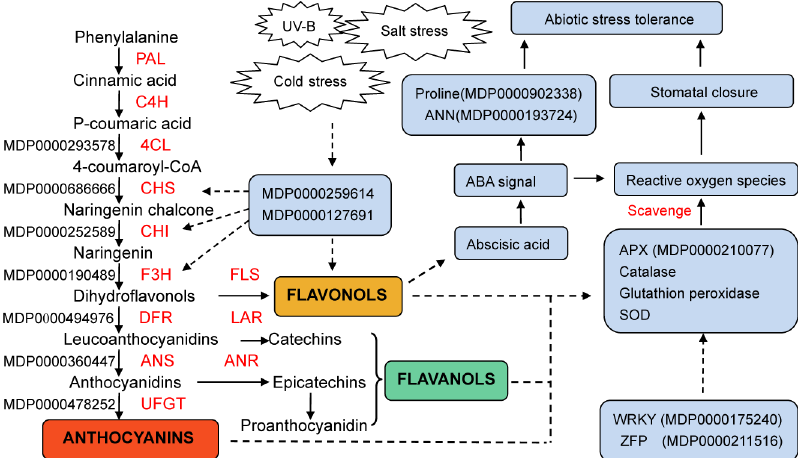
Fig 7. Model of the regulatory network involved in flavonoid metabolism and stress